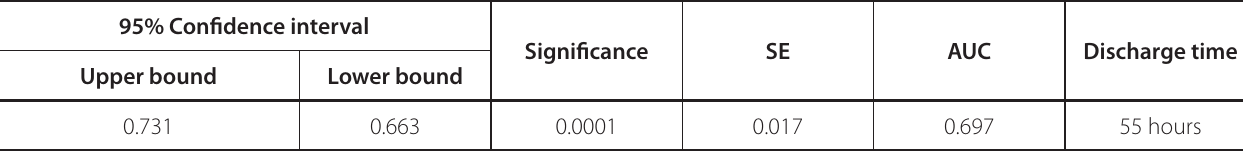
Table 3 . Area under the receiver operating characteristic curve of length of stay in intensive care unit after coronary artery bypass grafting.